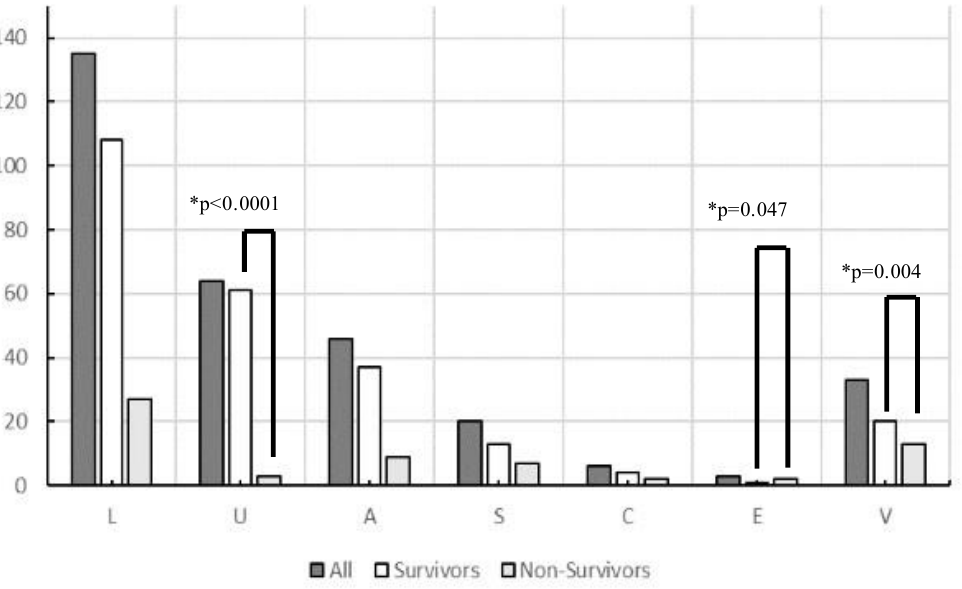
Figure 2. Origin of infection in survivors and non-survivors in this study ( n = 307). Abbreviations: L, lung; U, urinary tract; A, abdomen; S, soft tissue; C, central nervous system; E, endocardial systems; V, various other organs, including multiple infectious origins and cases of unknown origin. * Chi-square tests were performed to analyze the ratio of survivors and non-survivors. Table 2. Origin of infection in this study.